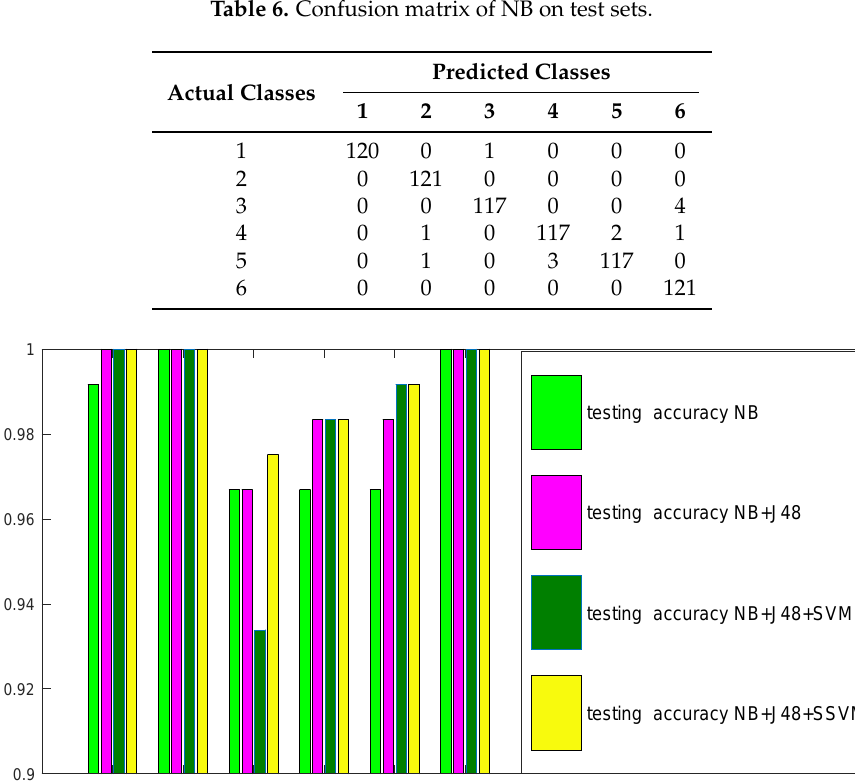
Table 6. Confusion matrix of NB on test sets.